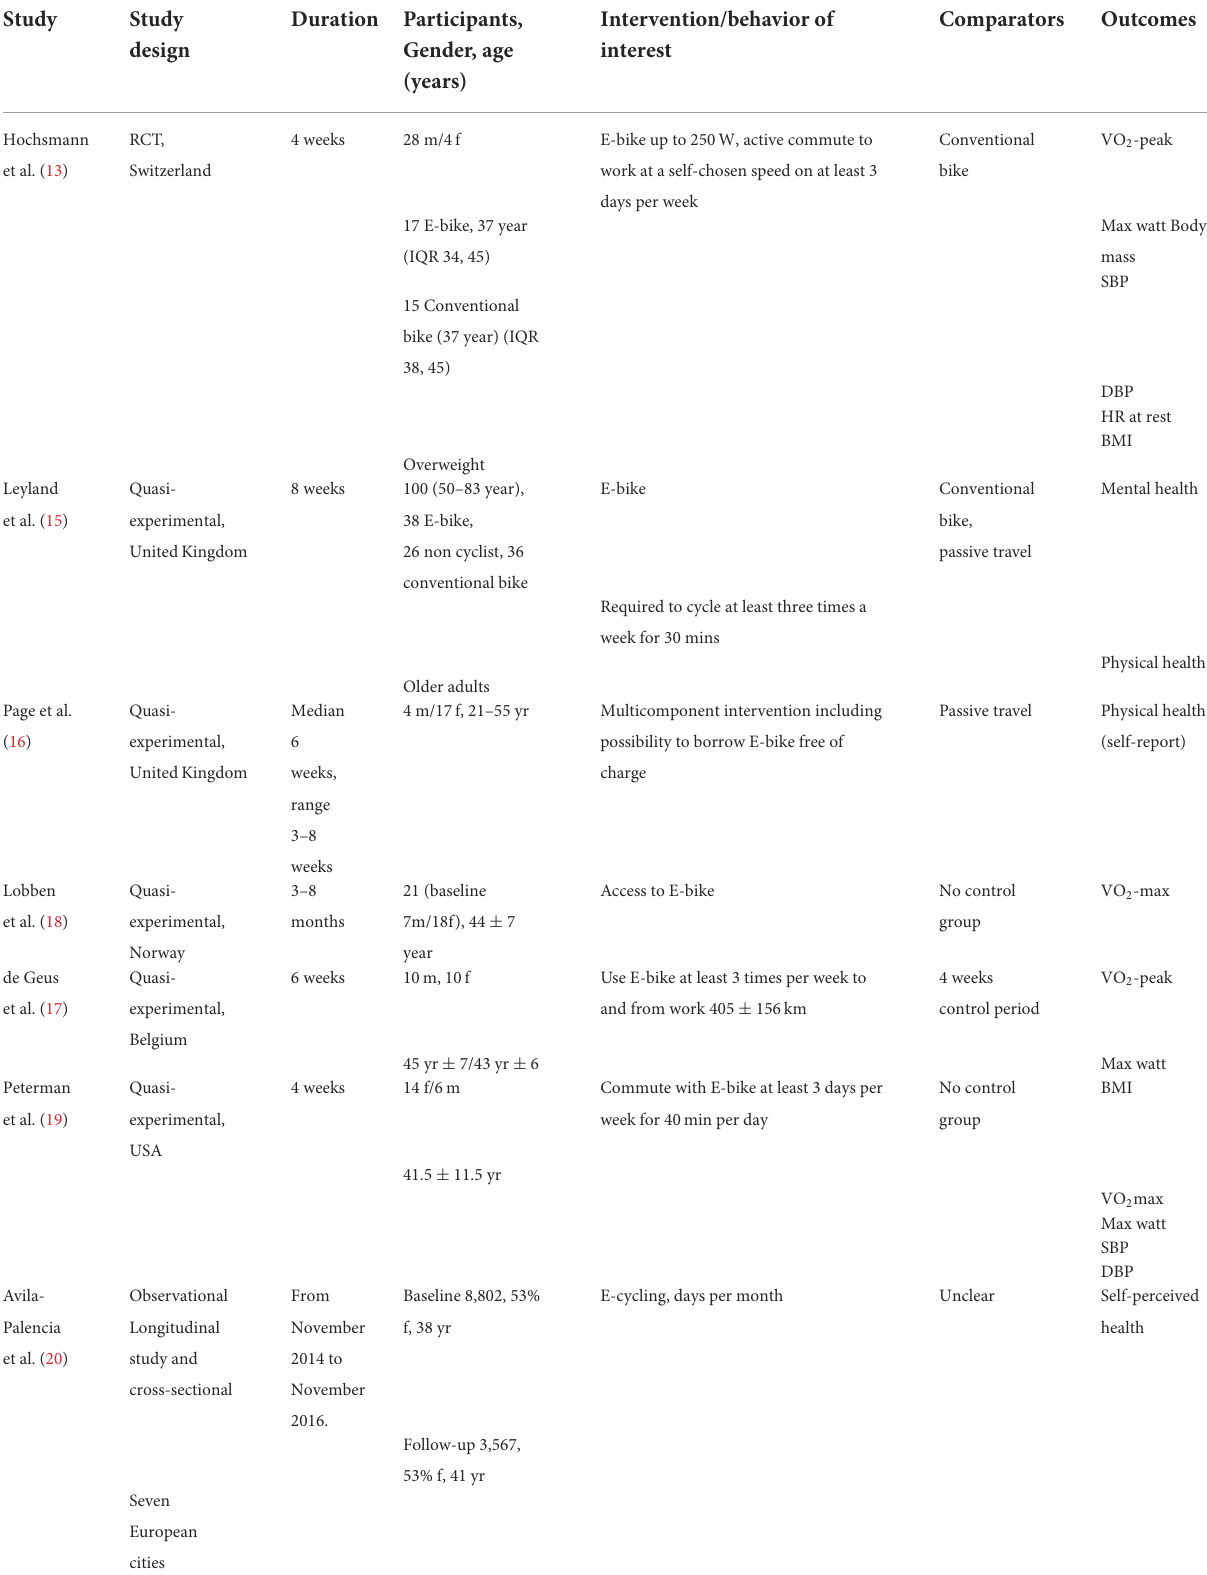
TABLE 1 Characteristics of the included